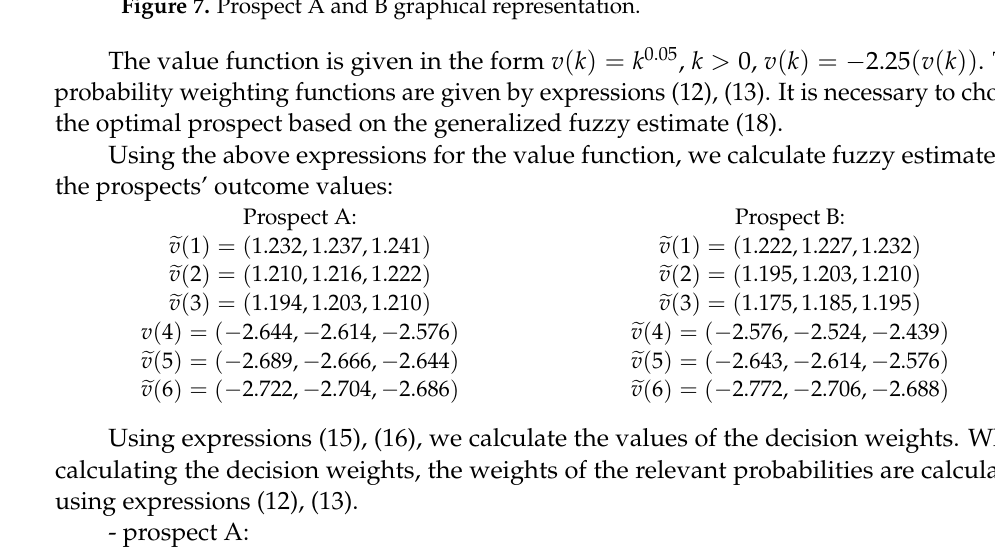
Figure 7. Prospect A and B graphical representation.